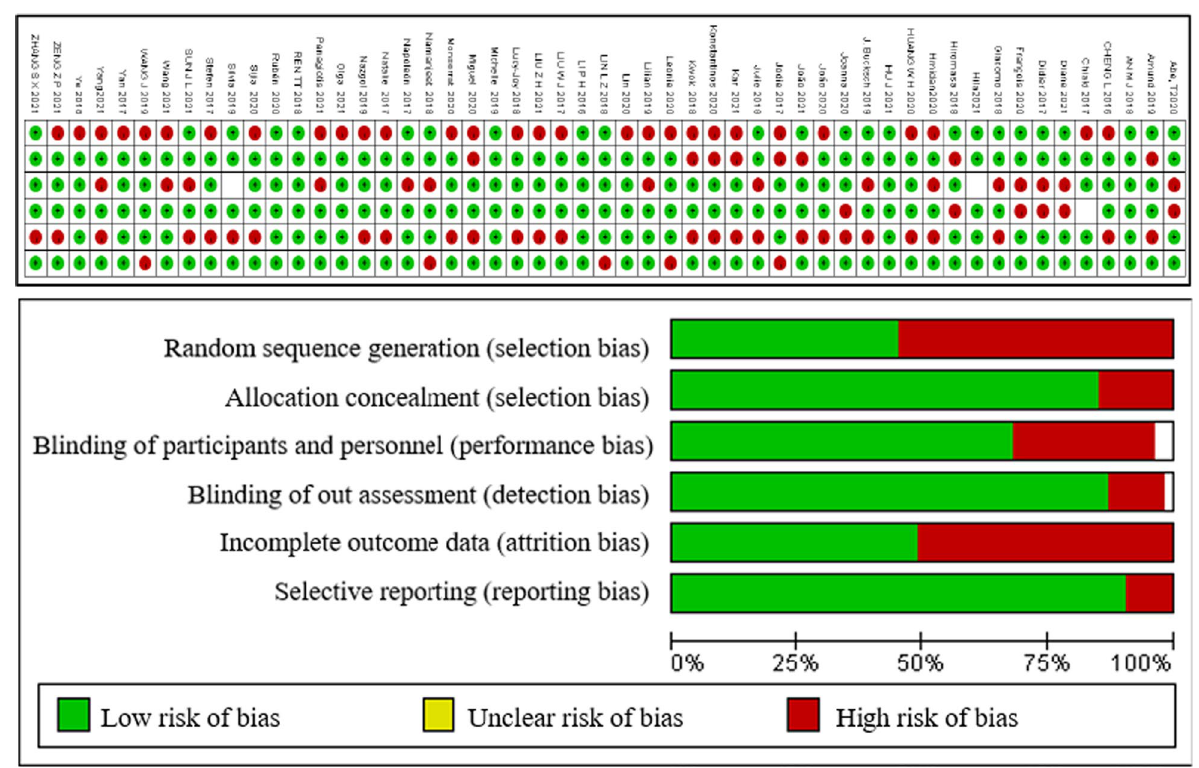
Fig. 2 Bias risk evaluation results of different included studies (red indicators high risk, green indicators low risk)